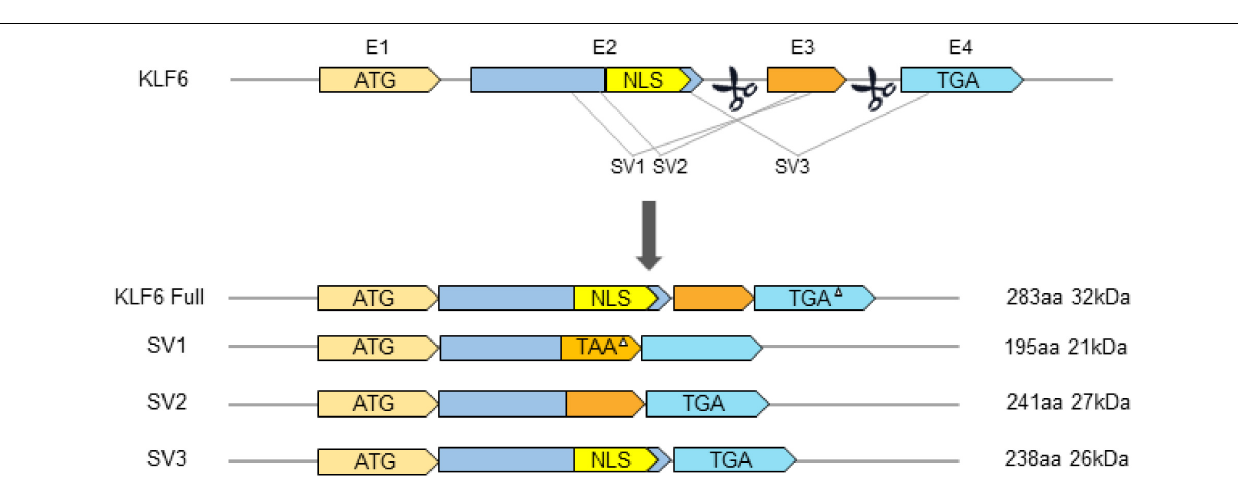
FIGURE 2 | Schematic diagram of gene structure of KLF6 and its splicing variants. E1–E4 indicates exons 1–4. TGA or TAA represents translation Stop codons. NLS, Nuclear Localization Signal. The triangle ( (cid:77) ) indicates that the Stop codon is in a different box from the KLF6 open reading